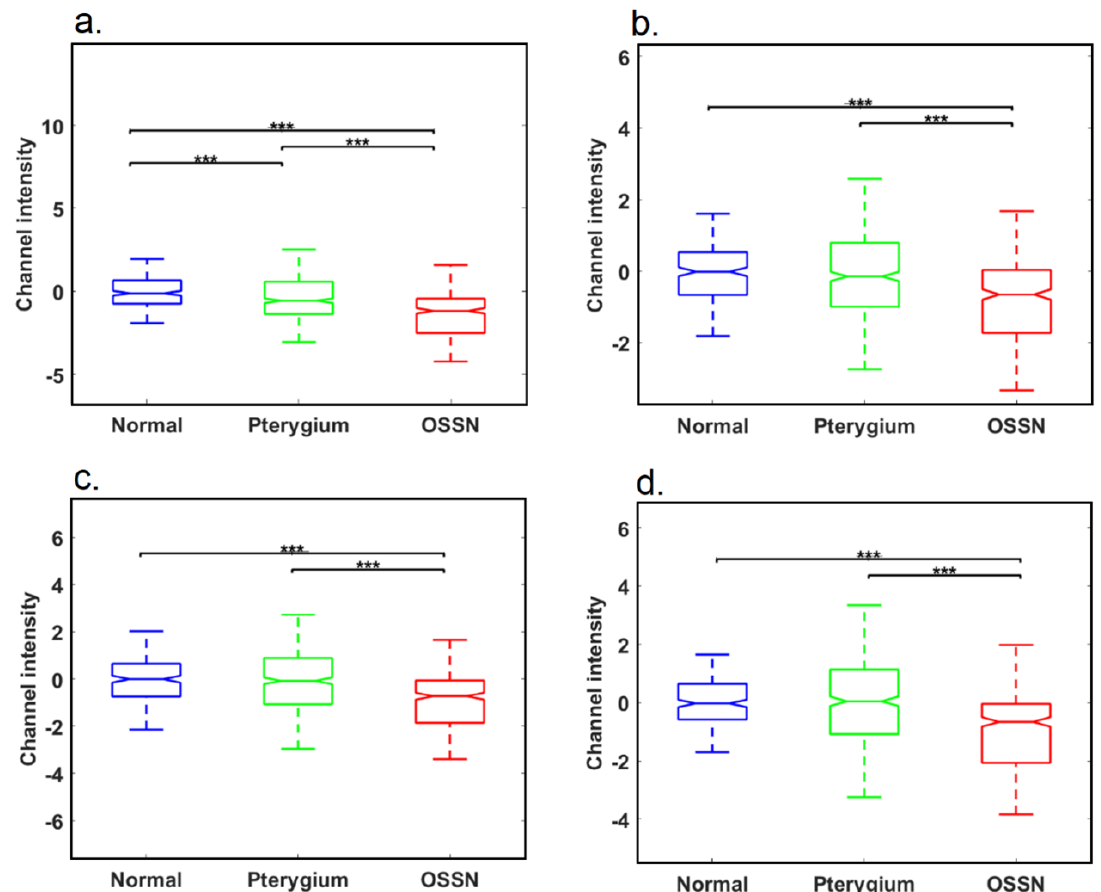
Figure 5. Analysis of fluorophore signals in the tissue. ( a ) Intensity analysis for Channel 3 containing a contribution from elastin. ( b ) Intensity analysis for Channel 12 containing a contribution from lipopigment. ( c ) Intensity analysis for Channel 30 containing a contribution from flavins. ( d ) Intensity analysis for Channel 52 tentatively attributed to PPIX (*** represents p − value < 0.01). Corresponding sample channels are shown in Supplementary Figure S3.